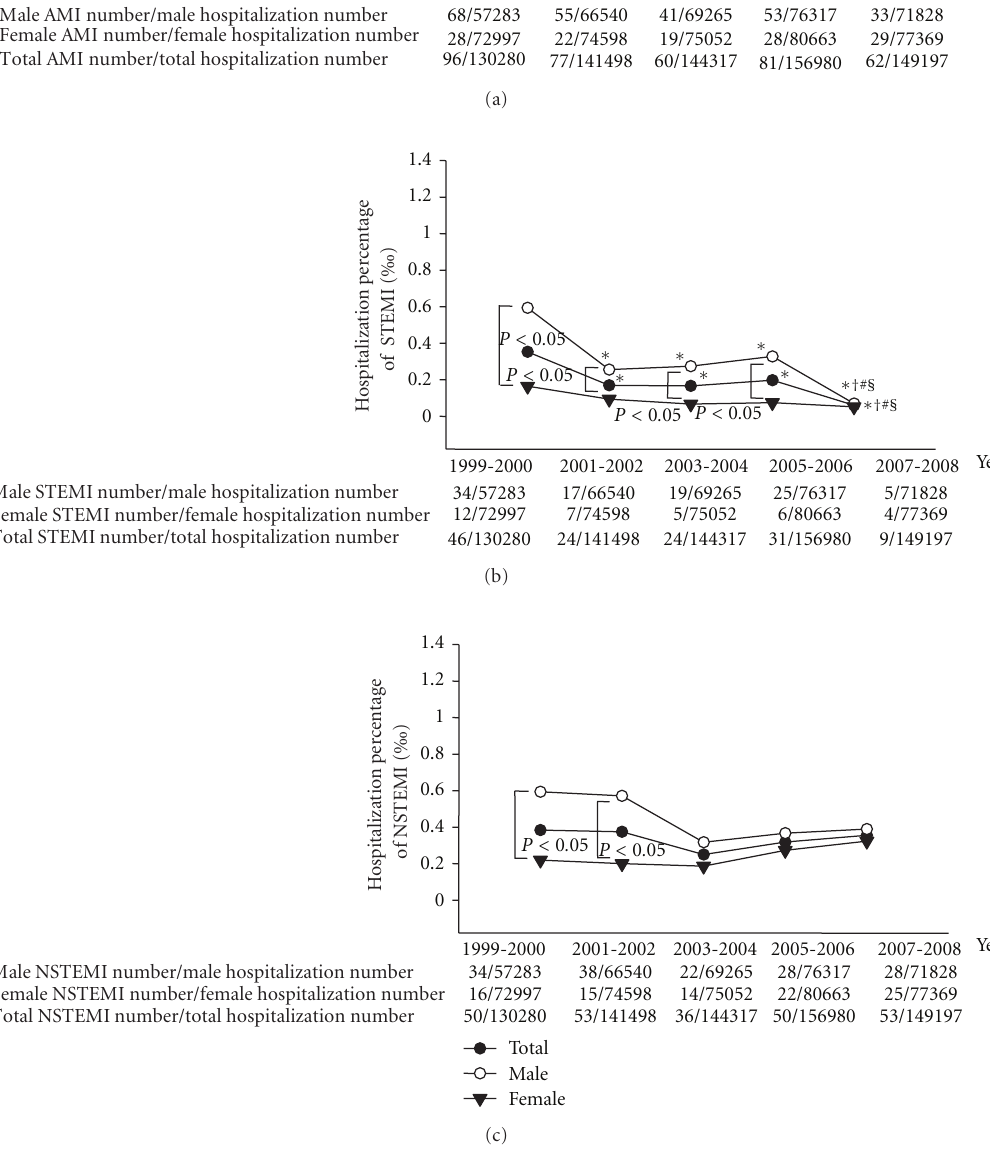
Figure 1: Hospitalization percentages of acute myocardial infarction (AMI, (a)), ST elevation MI (STEMI, (b)), or non-ST elevation MI (NSTEMI, (c)) from 1999 to 2008. ∗ P < 0 . 05 versus 1999 ∼ 2000, † P < 0 . 05 versus 2001 ∼ 2002, # P < 0 . 05 versus 2003 ∼ 2004, and § P < 0 . 05 versus 2005 ∼